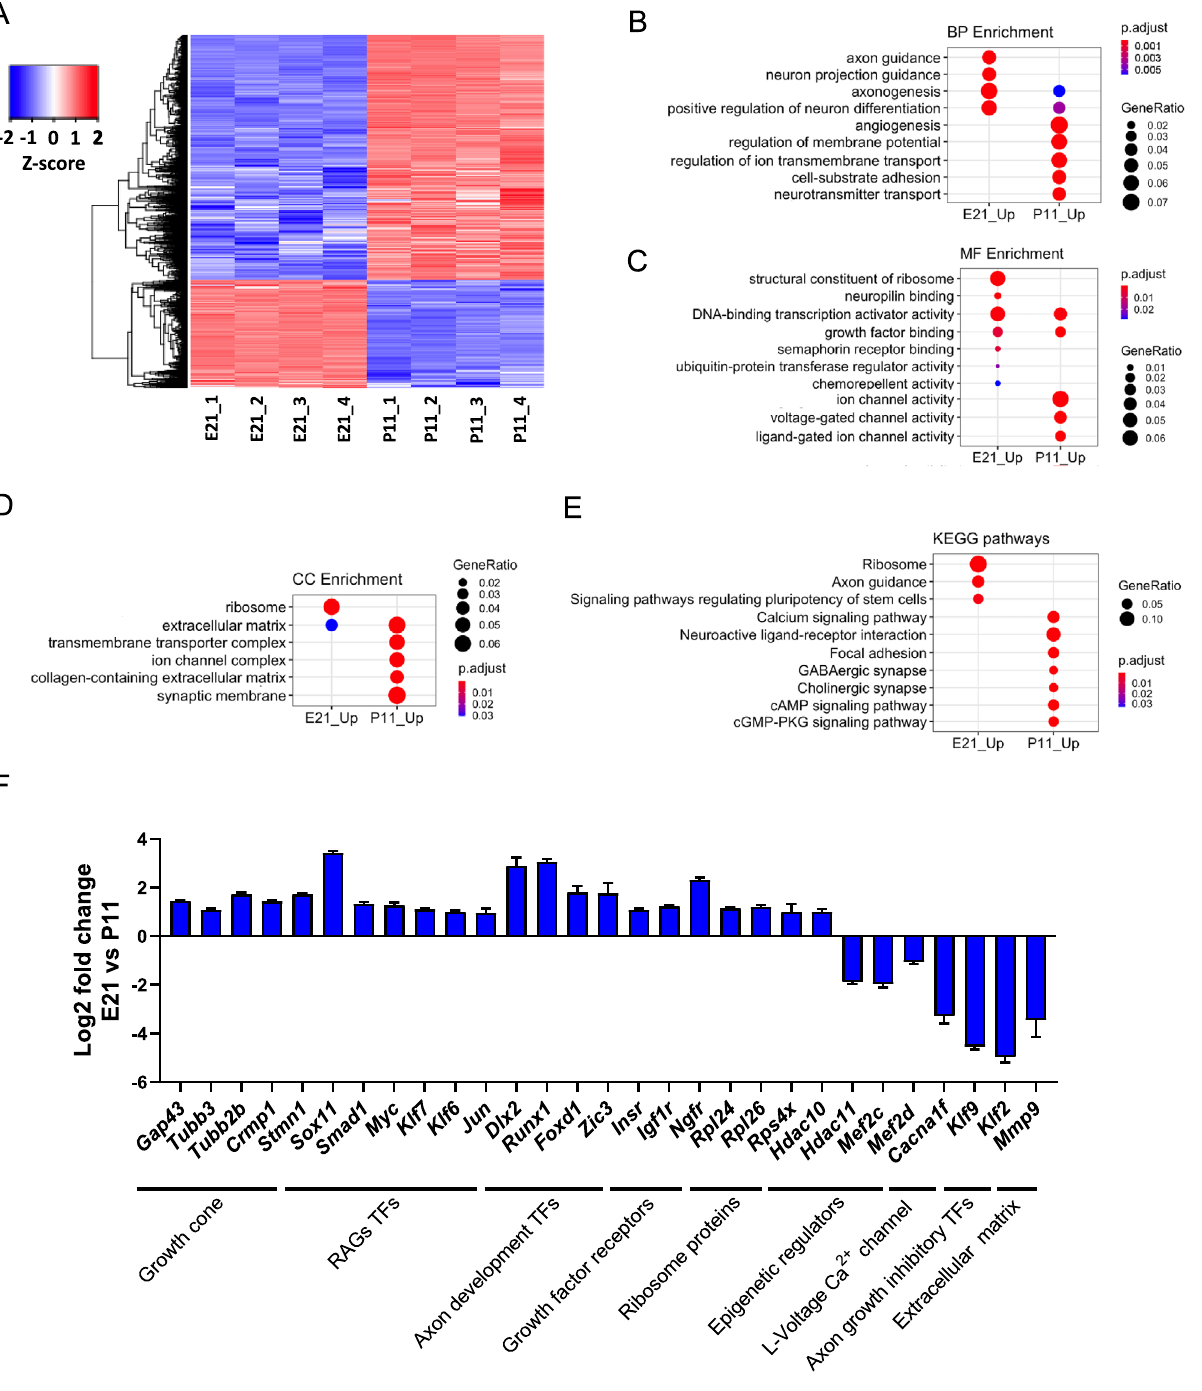
Figure 1. RNA-seq analysis of E21 and P11 purified RGCs. (A) Differentially expressed genes (DEGs) between E21 and P11. The cut off for DEGs displayed in the figure was log2 fold change > 1 and false discovery rate (FDR) adjusted p values < 0.01, which includes a Benjamini–Hochberg correction. Red represents gene expression above average expression level across all samples. Blue represents gene expression below average expression level across all samples. A total of 3,646 genes were differentially expressed, 1116 upregulated and 2530 downregulated in E21. (B–D) Gene ontology (GO) analysis of the DEGs. A subset of the most significantly enriched GO terms in (B) biological processes (BP), (C) molecular functions (MF) and (D) cellular component (CC) are represented. GO terms with a FDR corrected p value < 0.05 were considered as significant. (E) KEGG pathways analysis of DEGs. A subset of the twelve most significantly enriched pathways are represented. (F) Gene expression change between E21 and P11 of key individual genes from the most relevant pathways to axon growth in (B–D)